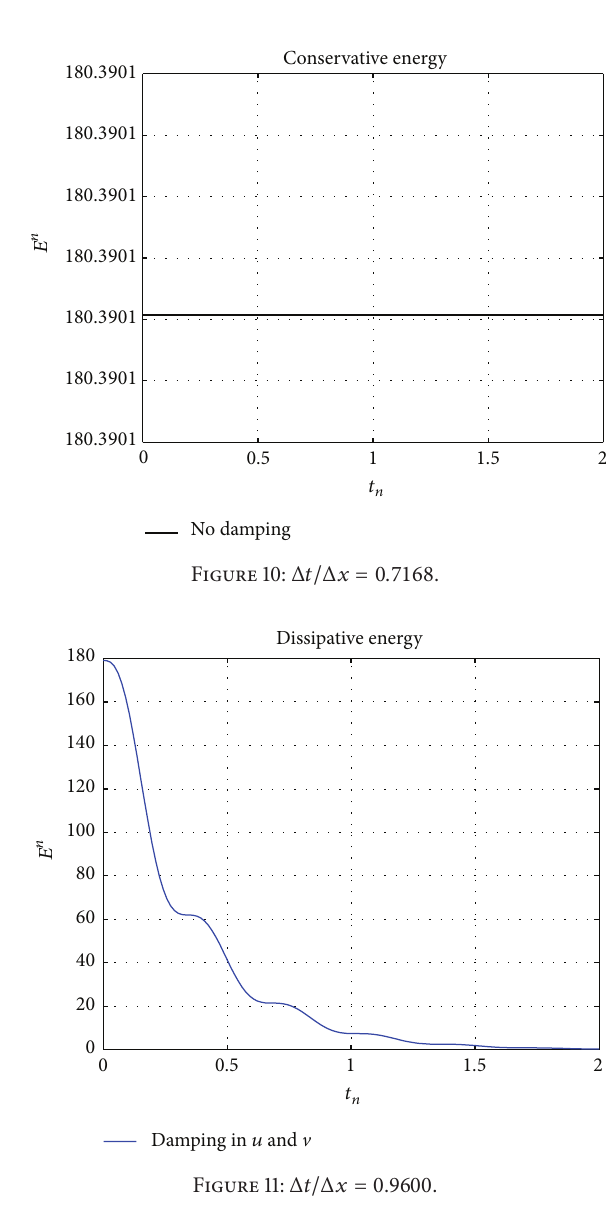
Figure 11: Δ𝑡/Δ𝑥 = 0.9600